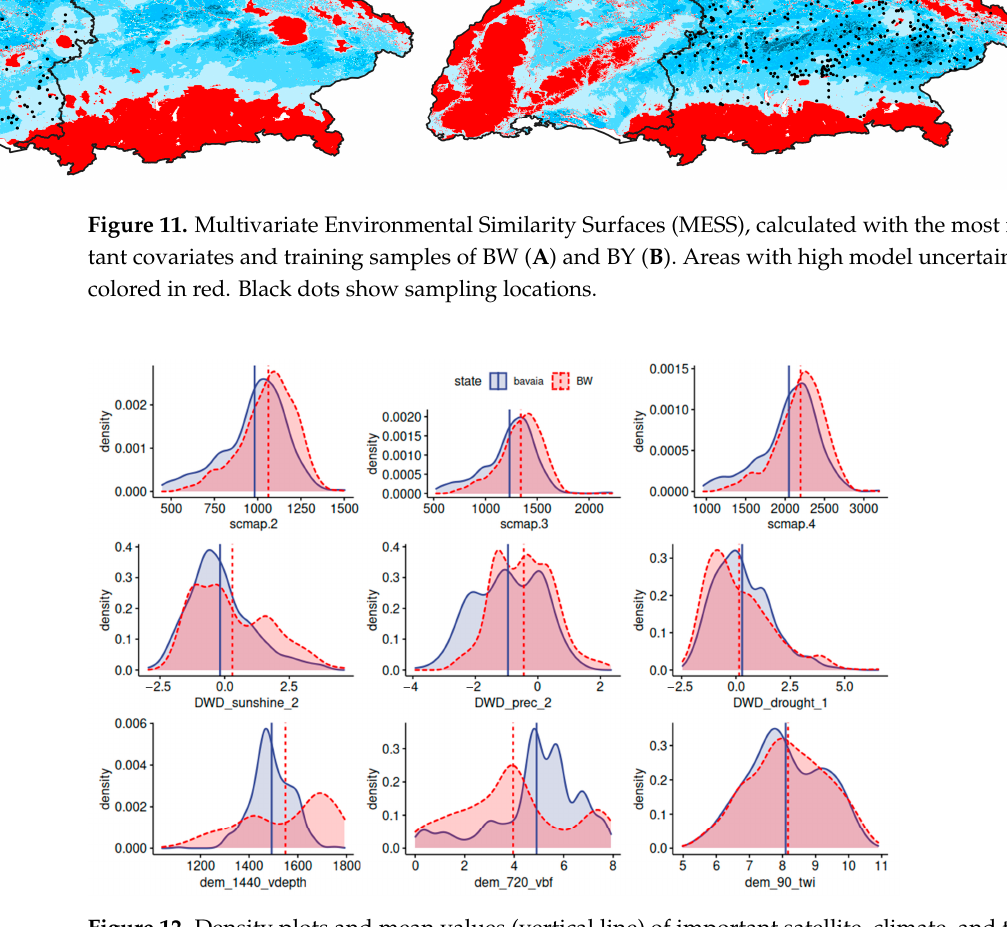
Figure 12. Density plots and mean values (vertical line) of important satellite, climate, and terrain covariates at the sampling locations of both states.